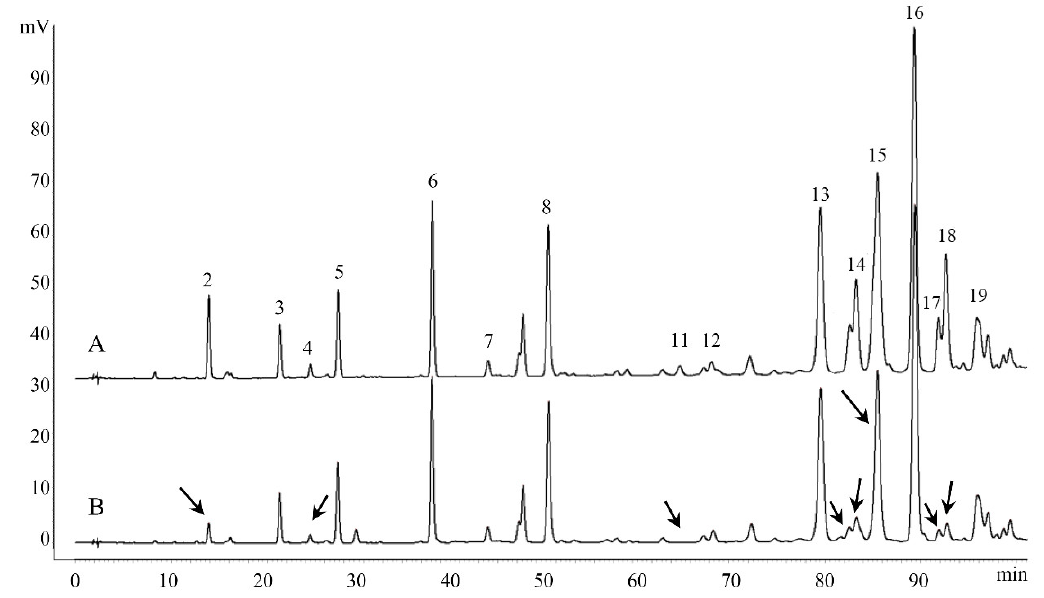
Figure 4. HPLC chromatograms of the Chinese propolis before ( A ) and after ( B ) reacting with DPPH radical. Arrows indicate peaks with a decreasing peak area.